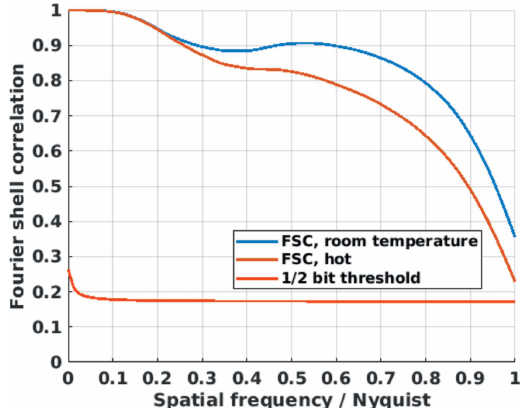
Figure 10 Fourier shell correlation (FSC) of the tomograms of the nanoporous gold sample. The curves suggest a spatial resolution of 19.4 nm, limited by the voxel size, for both the 50 (cid:2) C (room temperature) and 600 (cid:2) C (hot)